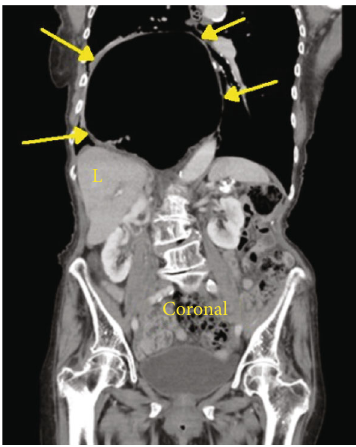
Figure 3: Coronal CT of chest and abdomen showing the large hiatal hernia located above the diaphragm with the liver “ L ”